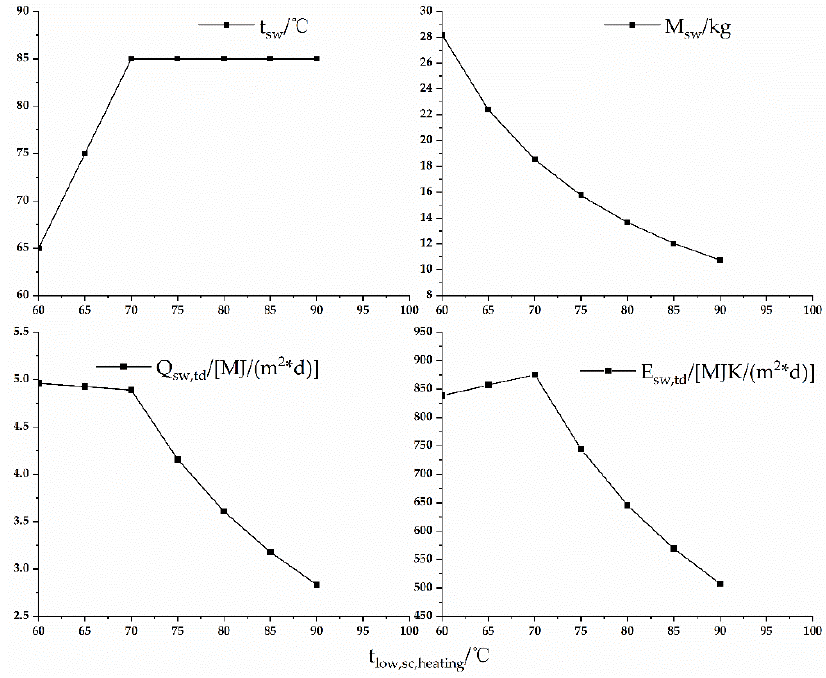
Figure 14. Variations in the key parameters with the low temperature of solar collection in the heating season.